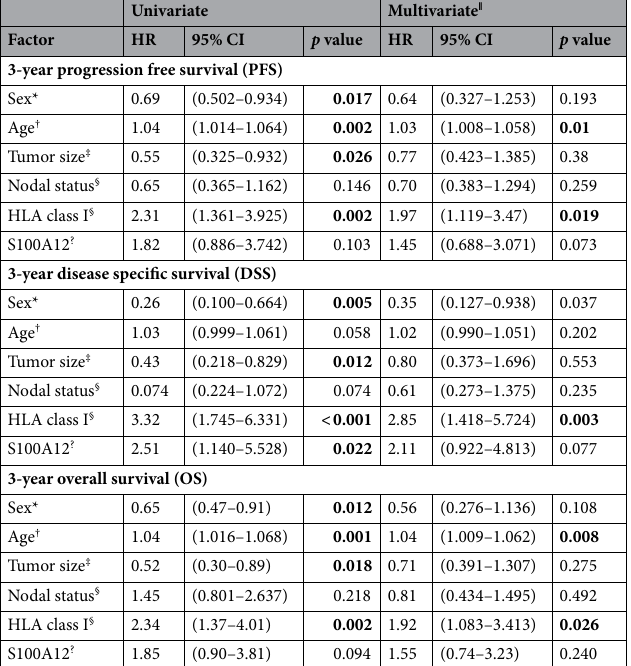
Table 4. Univariate and multivariate Cox regression analysis for 3-year survival in patients with HPV negative HPSCC. S100A12 expression dichotomized between 1/2 and 3/4. HLA class I and S100A12 evaluated separately in the multivariate analysis. HR hazard ratio, CI confidence interval. *Sex evaluated female vs male. † Age evaluated as a continuous variable. ‡ T-stage dichotomized between T1 + T2 vs T3 + T4. § HLA class I expression dichotomized between absent/low and medium/strong. ǁ Including all four